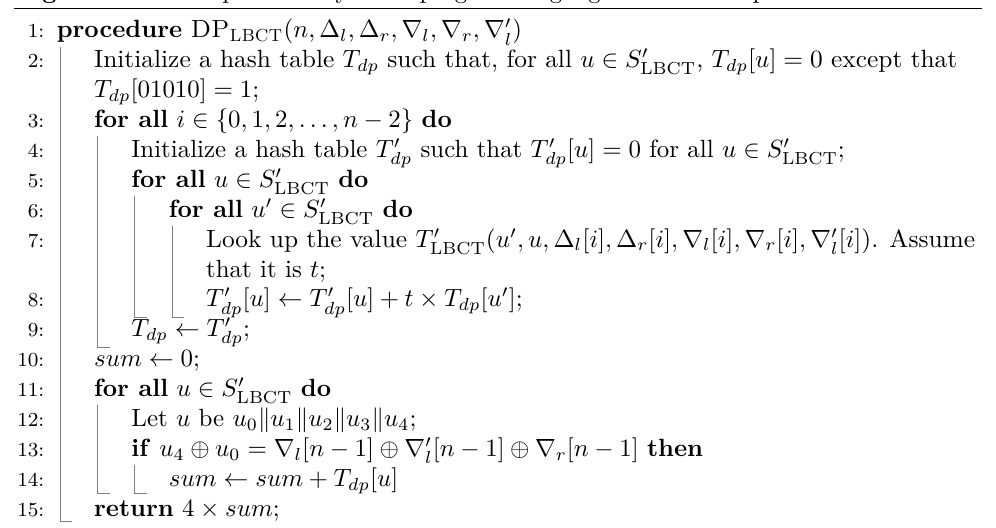
Algorithm 4 An optimized dynamic programming algorithm to compute entries of